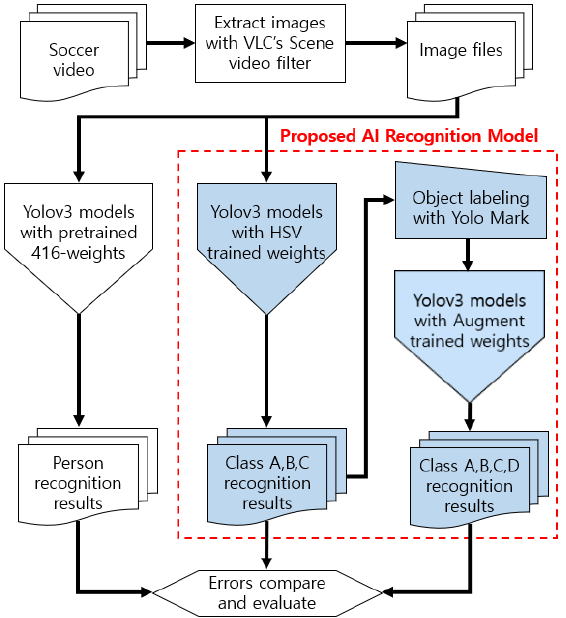
Figure 12. The object recognition procedure of the AI recognition models.